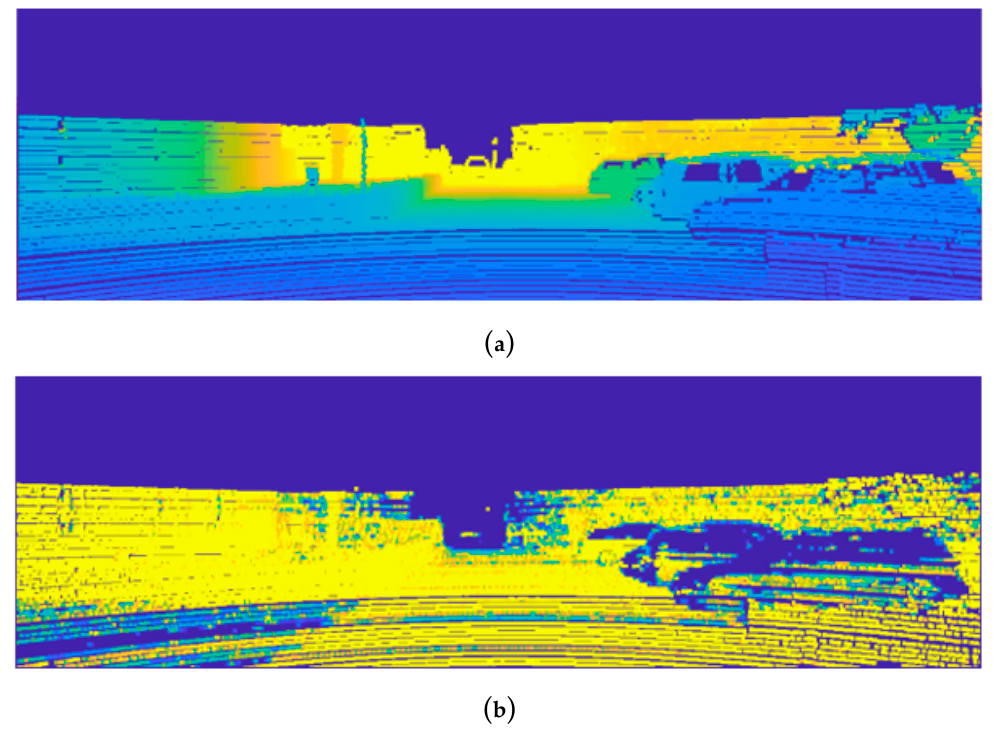
Figure 7. Scaled high-resolution PCD ( a ) depth map; ( b ) reflectance map.